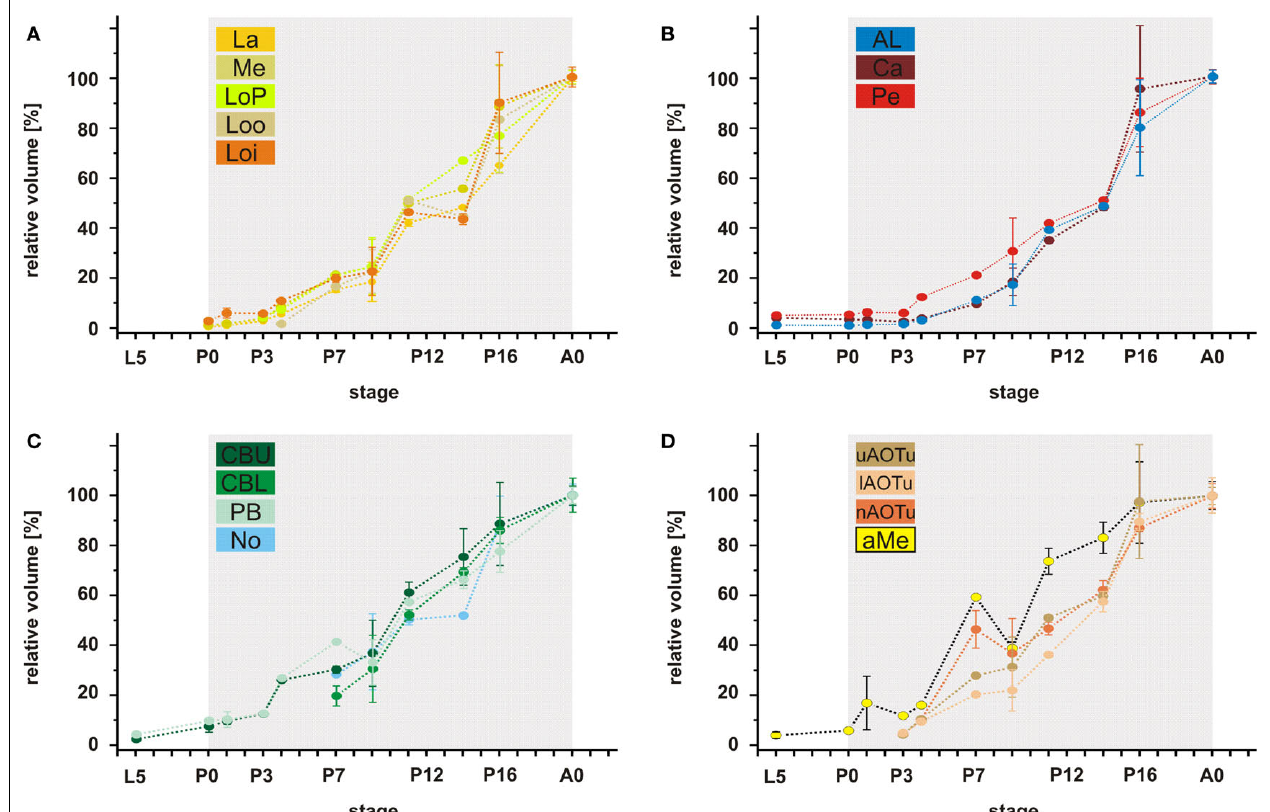
Deviation bars, standard errors. La, lamina; Me, medulla; LoP, lobula plate; Loo, outer lobula; Loi, inner lobula; AL, antennal lobe; Ca, calyx; Pe, pedunculus; CBU, upper unit of the central body (CB); CBL, lower unit of the CB; PB, protocerebral bridge; No, nodule; uAOTu, upper anterior optic tubercle (AOTu); lAOTu, lower AOTu; nAOTu, nodular subunit of the AOTu; a Me, accessory